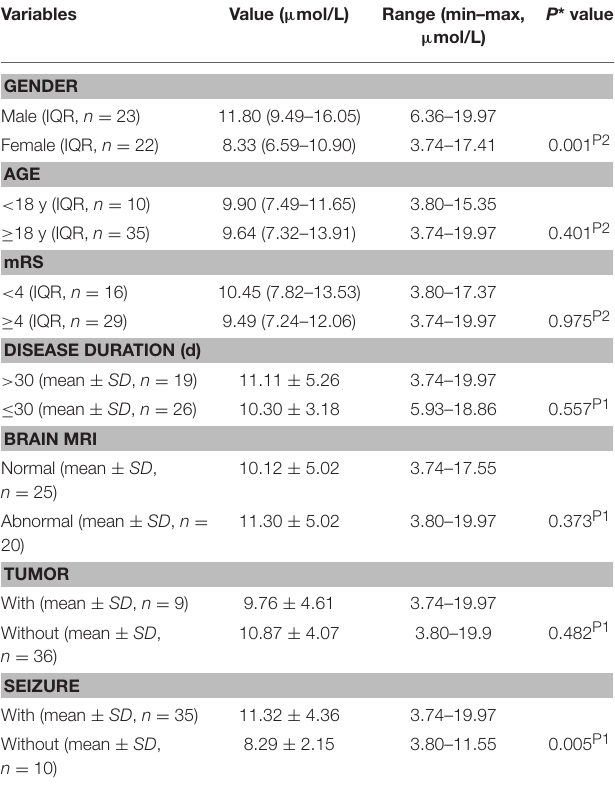
TABLE 3 | Comparison between Hcy concentration ≥ 10 µ mol/L and Hcy concentration < 10 µ mol in anti-NMDAR encephalitis patients. Anti-NMDAR encephalitis ( n =